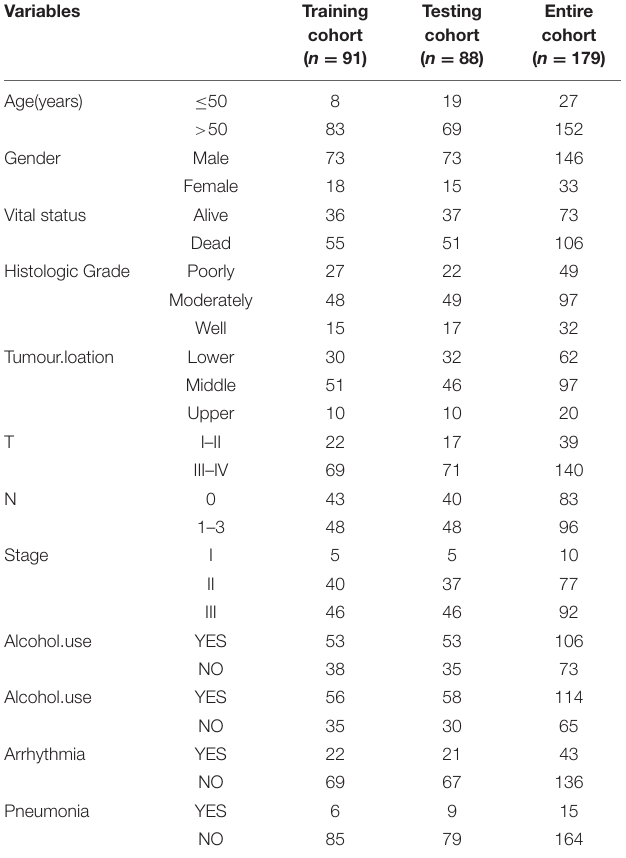
TABLE 1 | Clinical features of 179 esophageal carcinoma patients in GSE53625.